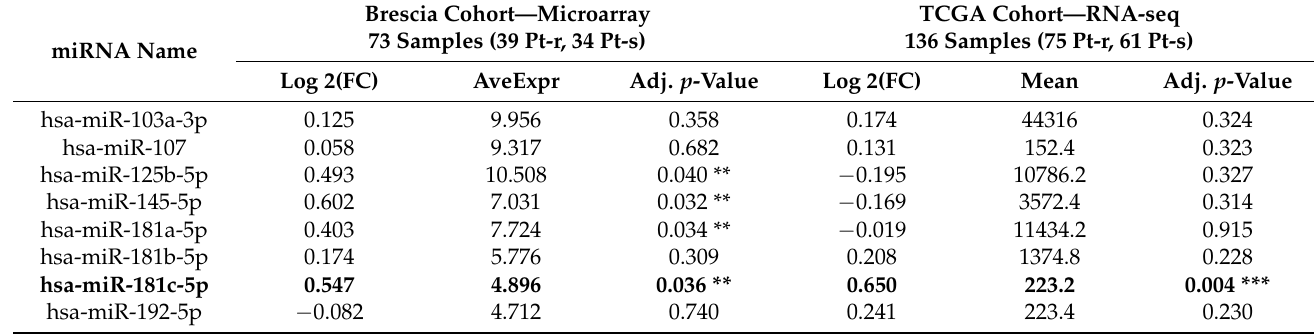
Table 2. Differential expression analysis. Differential expression analysis for 22 miRNAs in platinum-resistant (Pt-r) compared to platinum-sensitive (Pt-s)